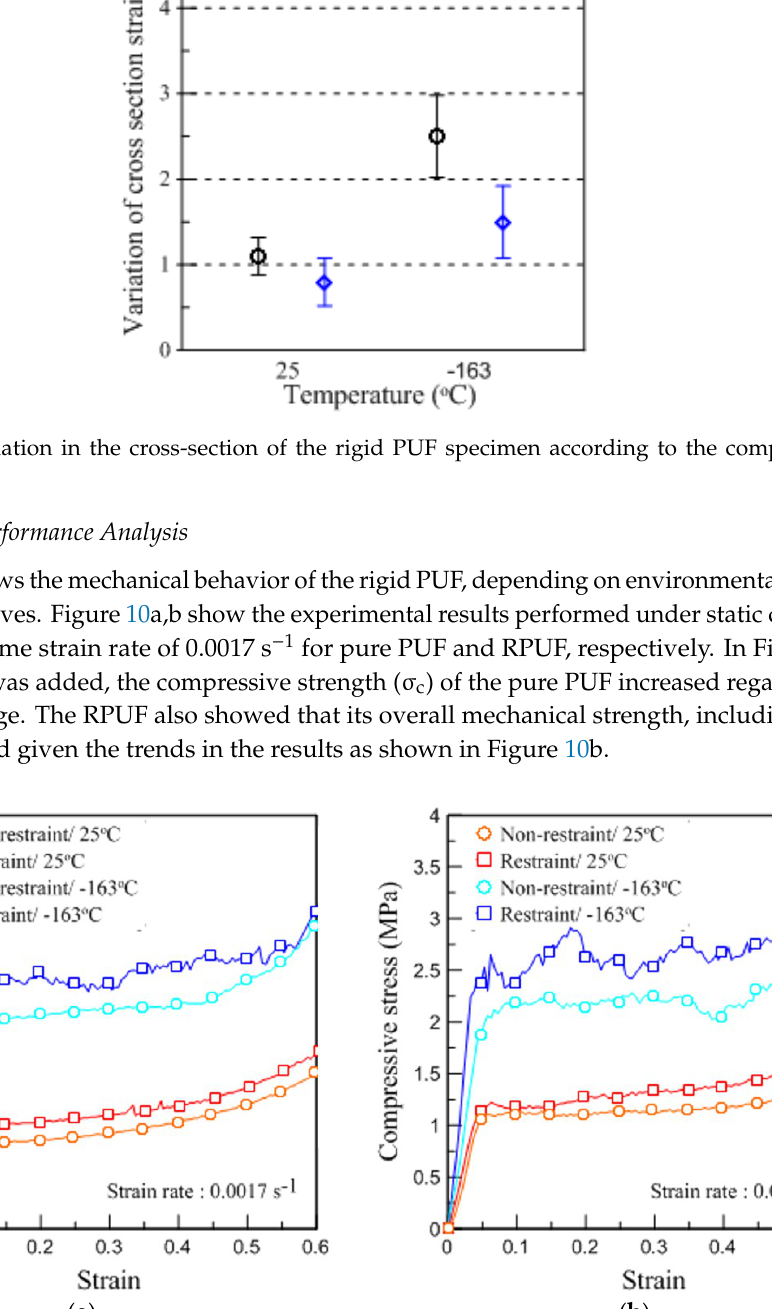
( b ) Figure 11. Dependences of the elastic modulus on restraint for ( a ) pure PUF and ( b ) RPUF. Table 6. Mechanical properties of pure PUF and RPUF specimens. Material